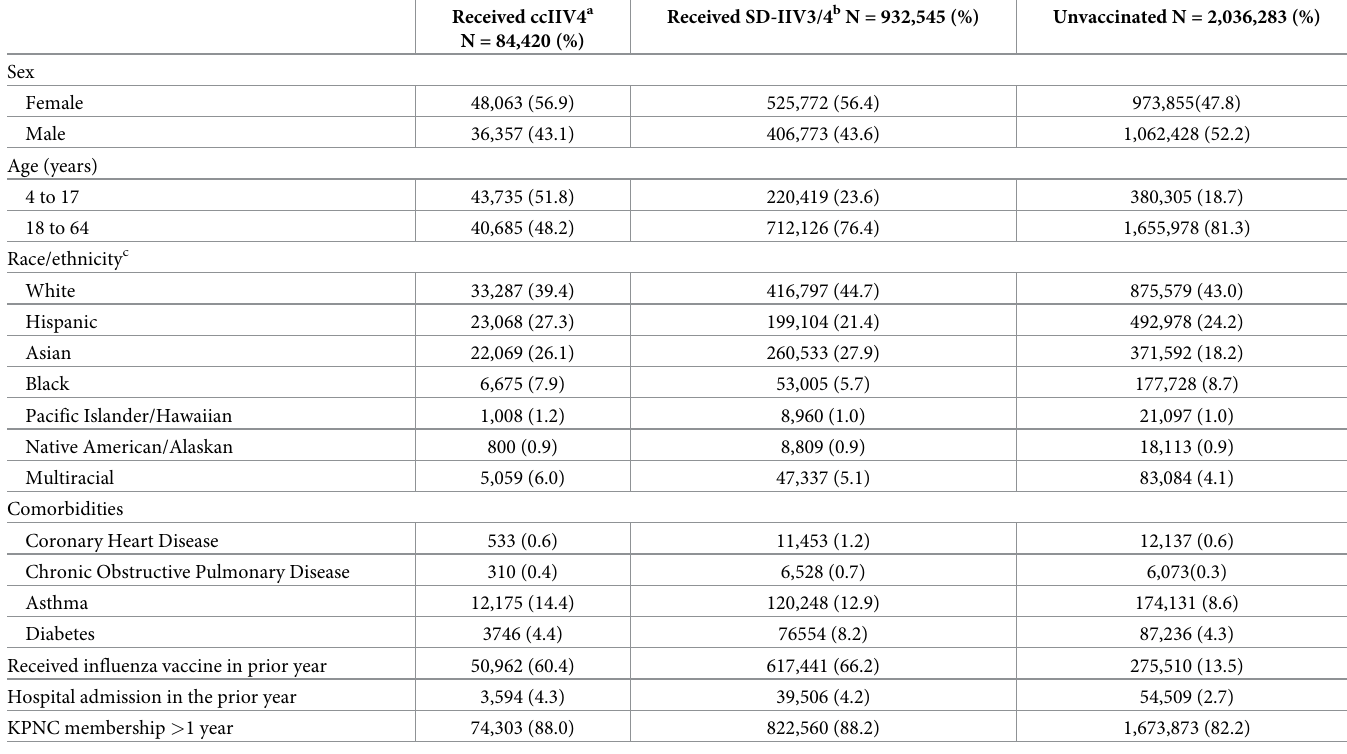
Table 1. Study population characteristics among 4-64-year-olds, Kaiser Permanente Northern California 2017–18.